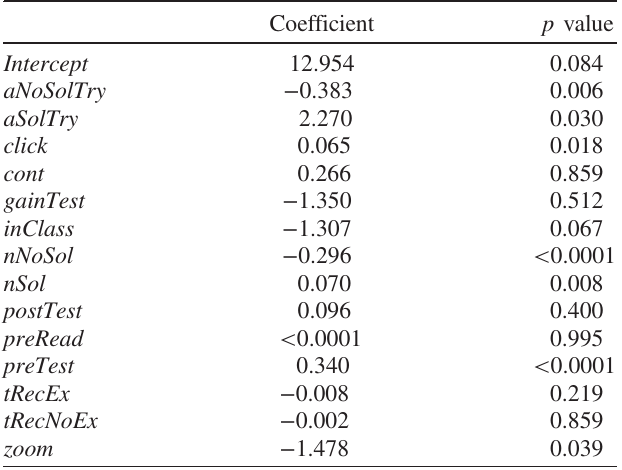
TABLE III. Multiple linear regression coefficients and p values for the prediction of the combined quiz and final exam scores.